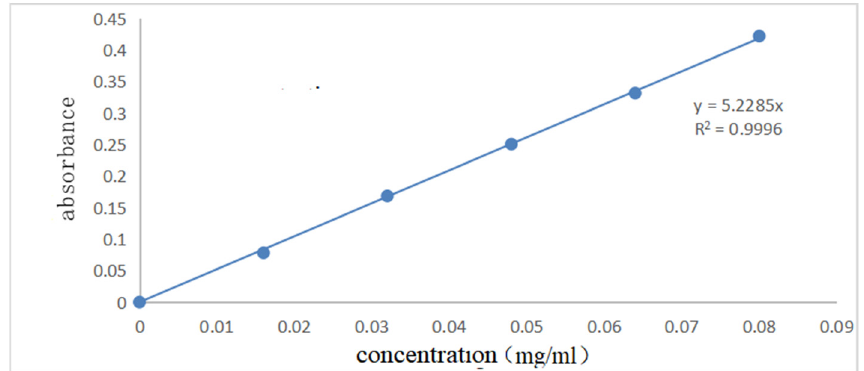
Figure 8. Standard curve of ultraviolet spectral absorption of CR (340 nm).